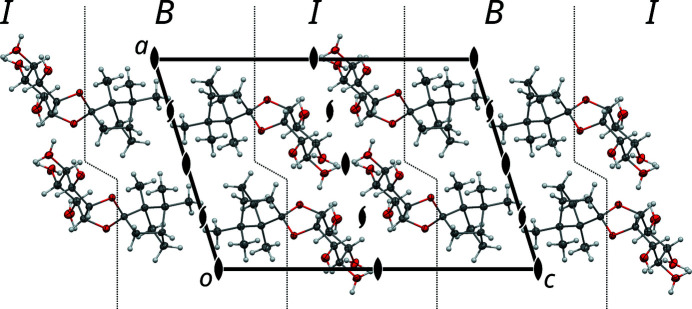
The disordered basic structure of 1 viewed down [010]. Atom colors as in Fig. 4 ▸. Symmetry elements are indicated using the common graphical symbols (Hahn & Aroyo, 2016 ▸). Dotted lines indicate the boundaries between the B (bornane) and I (inositol) layers. Hydroxyl H atoms are overpopulated owing to disorder.